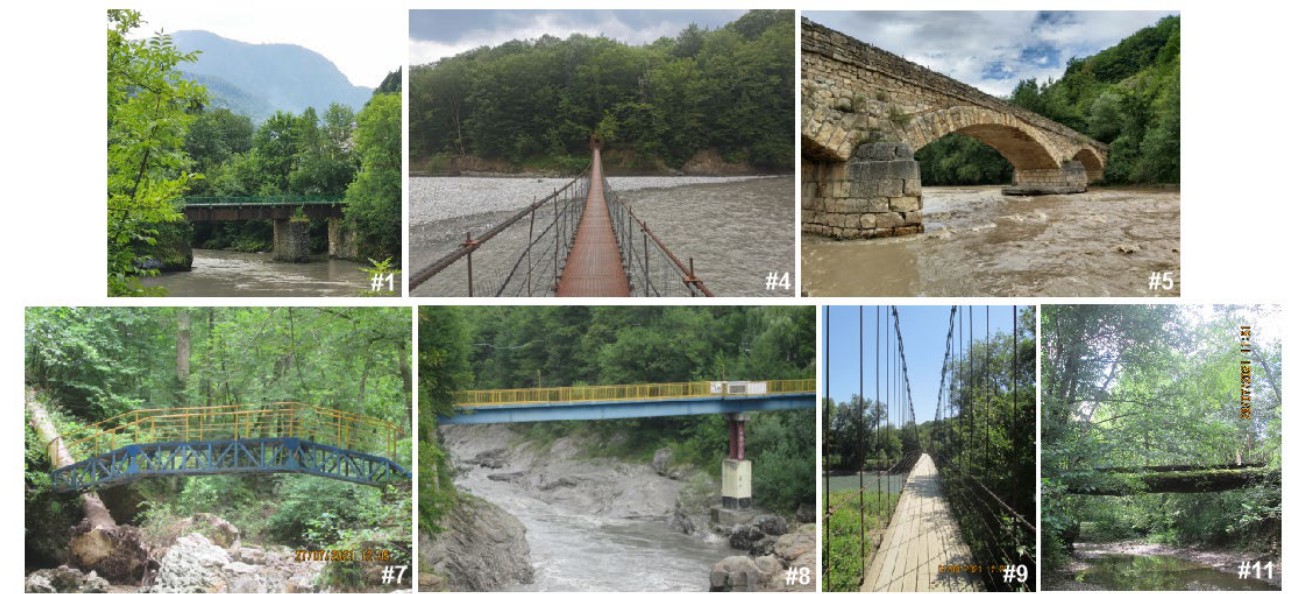
Figure 2. Selected bridges of the study area. IDs correspond to Figure 1 and Table 2. Table 2. Semiquantitative assessment of the bridge-based geoheritage viewpoints of the Mountainous Adygeya geodiversity hotspot. (Table 2). First of all, the bridges provided different possibilities for viewing geoheritage. Criteria (See Table 1 For Abbreviations and Scoring ID Locality (River) Type